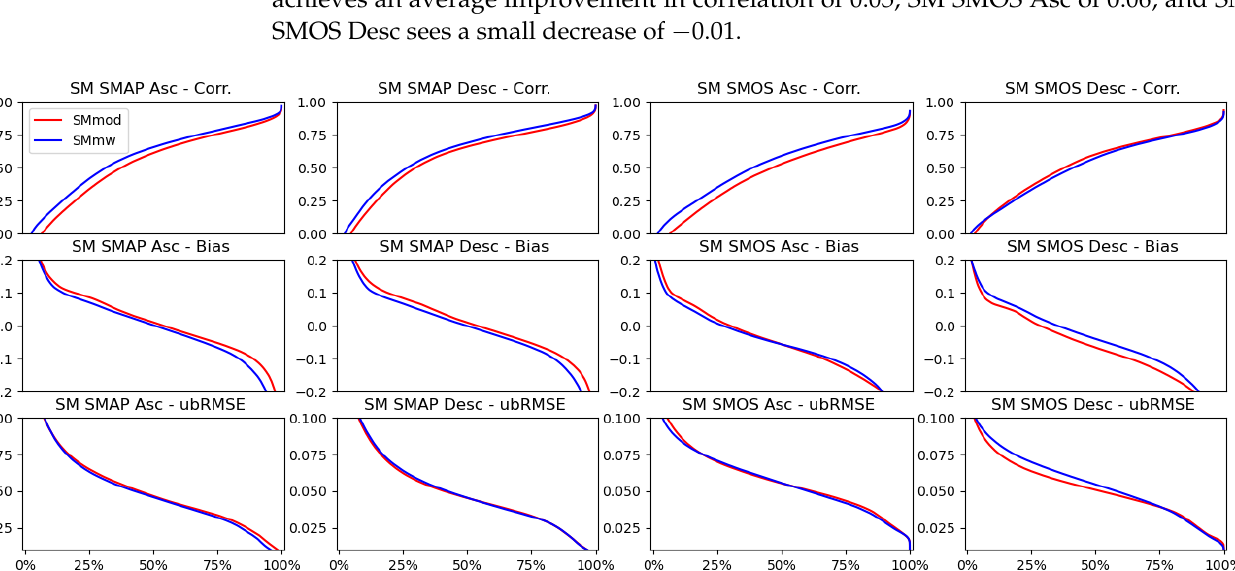
Figure 5. Cumulative plots of global SMAP Asc, SMAP Desc, SMOS Asc, and SMOS Desc SM mw and SM mod retrievals compared to ERA5. Results are shown for correlation, bias, and ubRMSE.